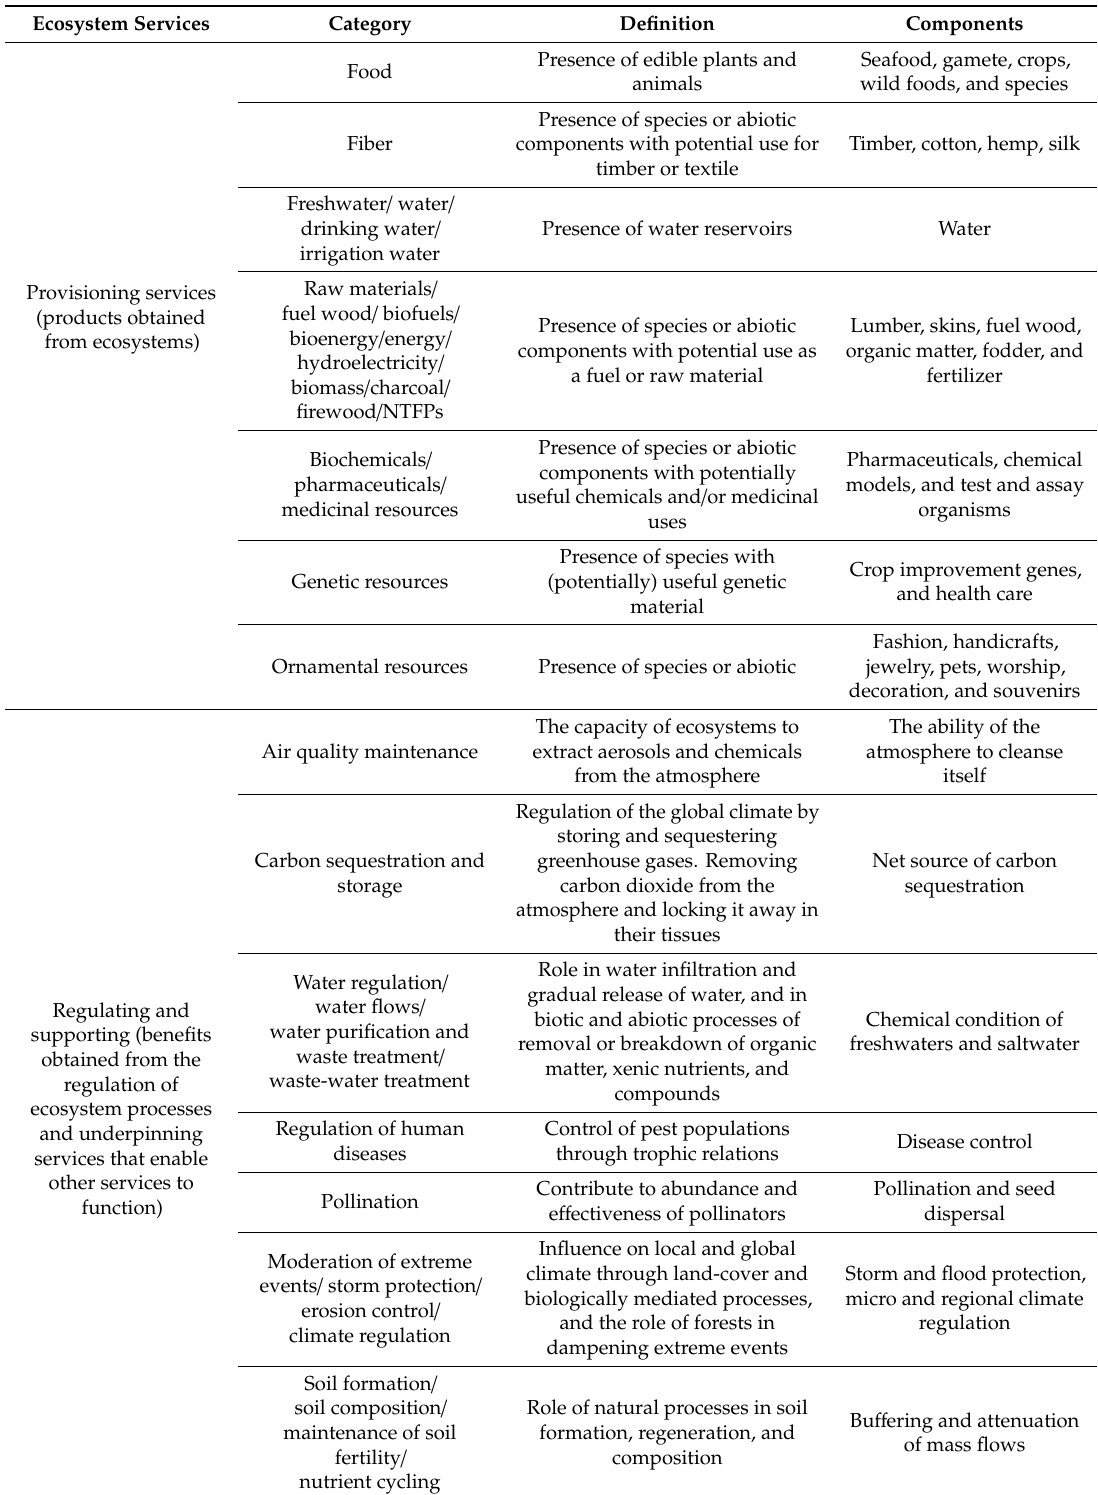
Table 2. Ecosystem service types and components